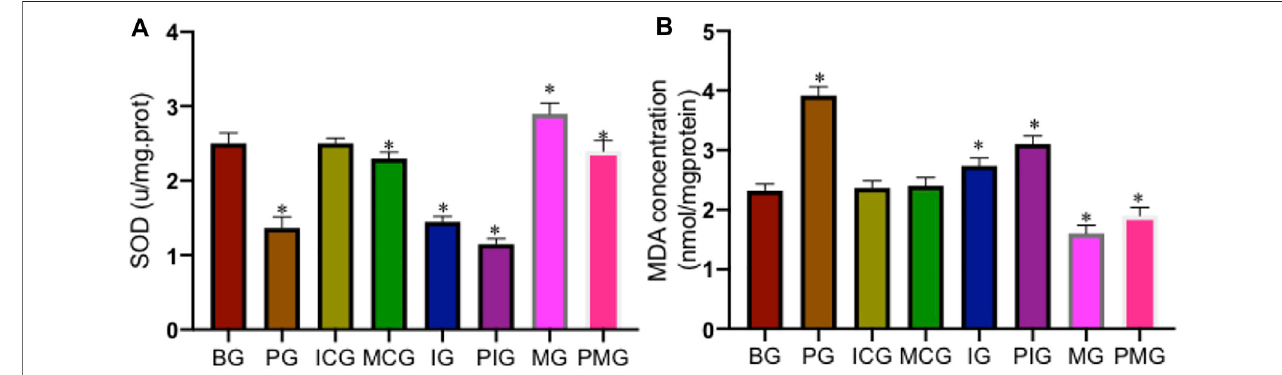
FIGURE 5 | The levels of oxidative biomarkers of lung injury among different groups. (A) , SOD activity. (B) , MDA concentration. n = 3 for each group. * p < 0.05 vs. the BG group.